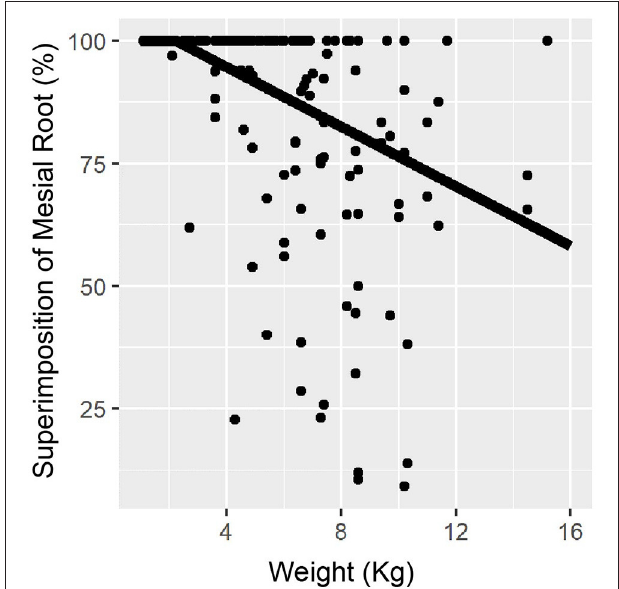
FIGURE 5 | Relationship between mesial root superimposition and weight. Mesial root showed 100% of superimposition with the mandibular canal (MC) for patient < 2kg. Dogs heavier than 2kg showed decreasing superimposition with the MC at a steady rate.